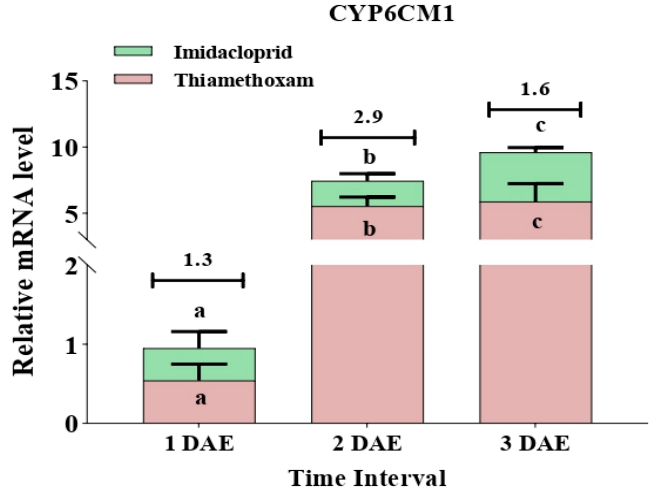
Figure 7. Expression of the insecticide-resistant gene ( CYP6CM1 ) in whiteflies after exposure to sublethal doses of imidacloprid 17.8 SL and thiamethoxam 25 WG at various durations (1 DAE, 2 DAE, and 3 DAE). Bars represent the standard error of the mean (SEM), and the different letters above the symbols indicate a significant difference at the 0.05 level. DAE: days after exposure.